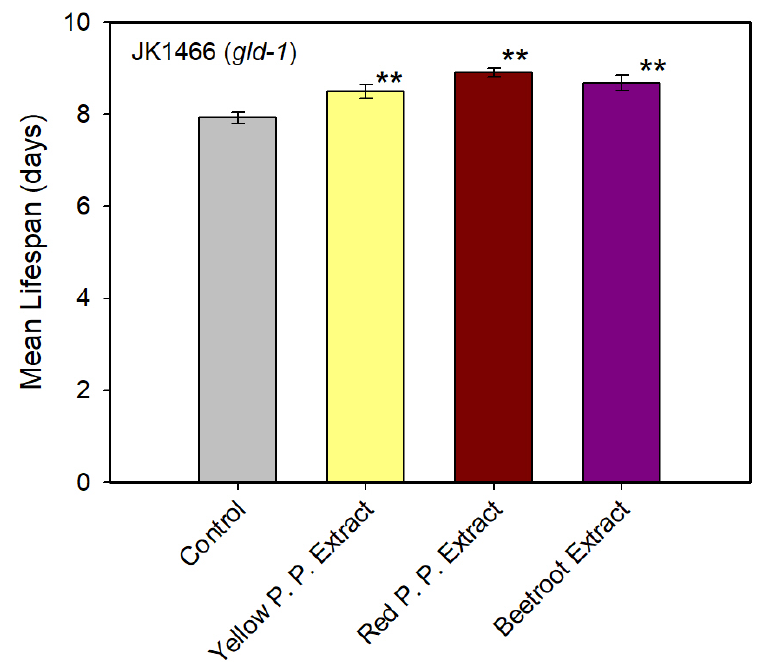
Figure 3. Mean lifespan of JK1466 mutant worms treated with natural extracts at 1% w/v . Mean lifespan (mean ± SE) is shown for C. elegans gld-1 mutants which were treated with yellow ( n = 60) and red ( n = 46) prickly pear extracts and beetroot extract ( n = 65), and without treatment (control) ( n = 48). ** indicated p ≤ 0.05.